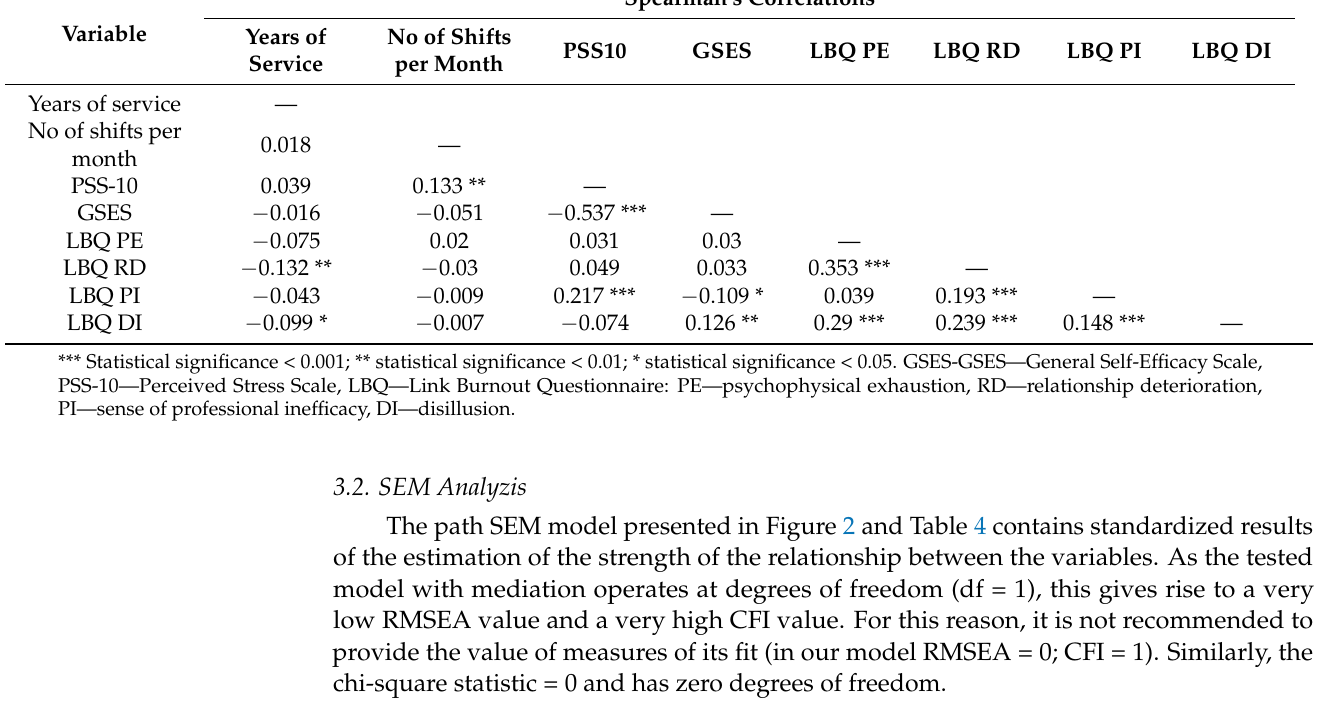
Table 3. Spearman’s correlations between the variables in a group of Polish ECDs (N = 546). Variable